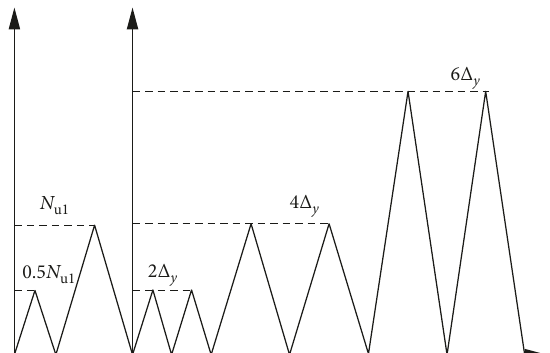
Figure 3: Cyclic loading program of stub columns of group-c.